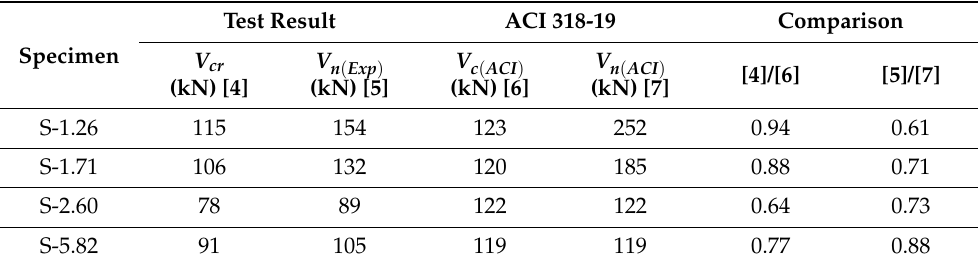
Table 5. Test results for the specimens governed by